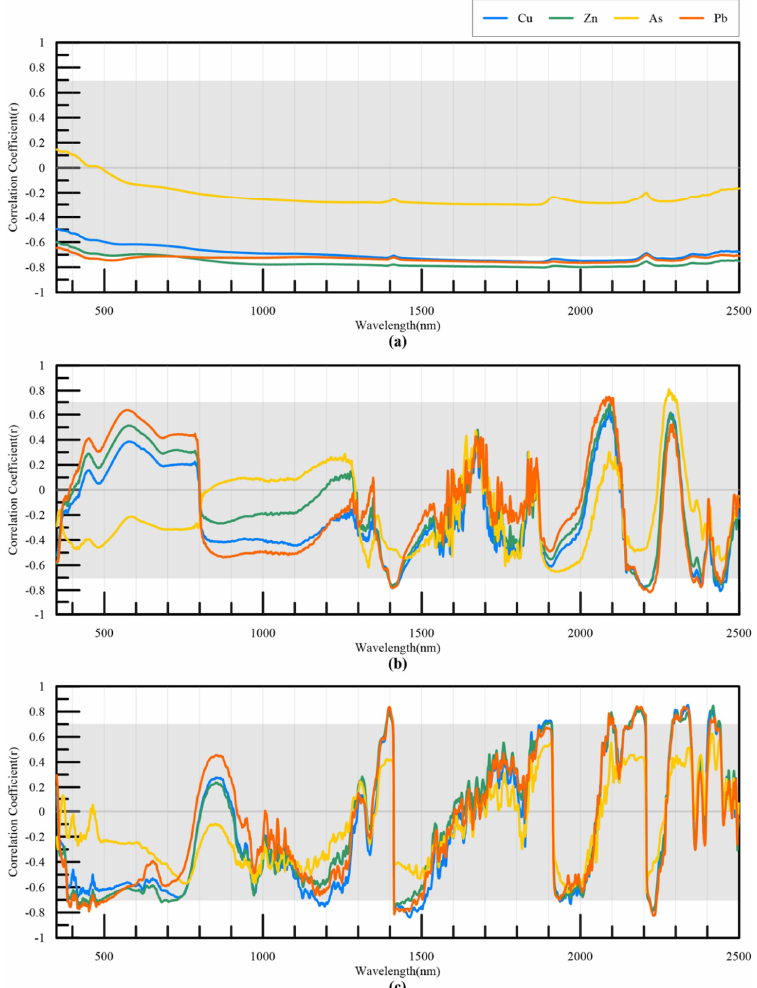
Figure 6. Correlograms between heavy metal concentration and ( a ) reflectance, ( b ) absorption depth, and ( c ) first derivatives of Group A. Compared to the Group A samples, the spectral variables of Group B samples showed relatively weaker correlations with heavy metal elements (Figure 7). The correlation between reflectance and heavy metal concentration was not statistically significant for most of the spectral bands except for the spectral region of 1900 nm and >2400 nm with positive correlation with As concentration (Figure 7a). The correlation between absorption depth and heavy metal concentration was statistically significant for 420 nm (As) and 900–1400 nm (Zn and Pb) with negative correlation (Figure 7b). It indicates that heavy metal cations of As, Zn, and Pb are geochemically adsorbed to iron oxides and